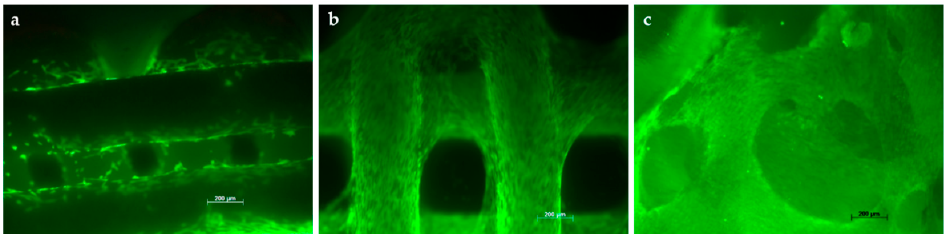
Figure 4. Colonization of cubic scaffolds with MSCs: Scaffold B ( a ), Scaffold D ( b ) and BioOss ® ( c ) after 28 days. (Live/Dead-staining).